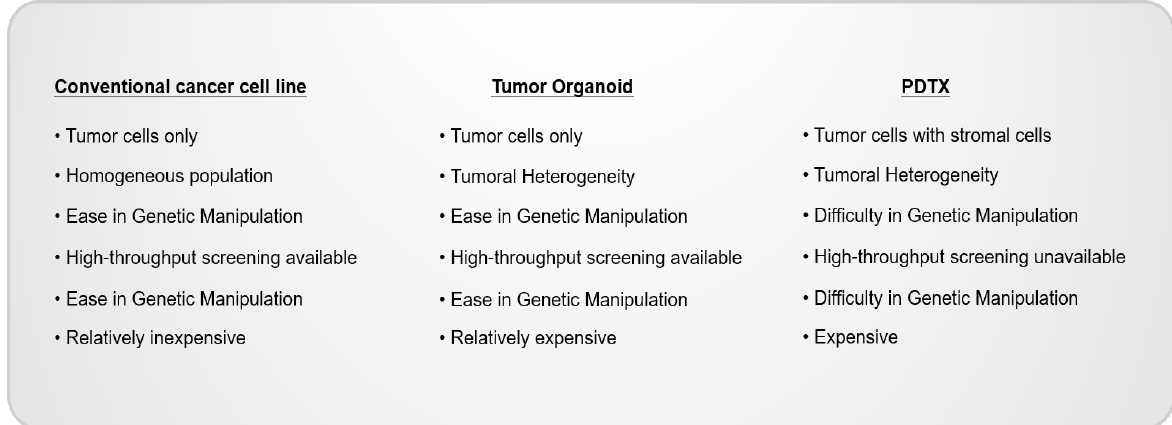
Figure 1. Overview of general cancer models, at present.